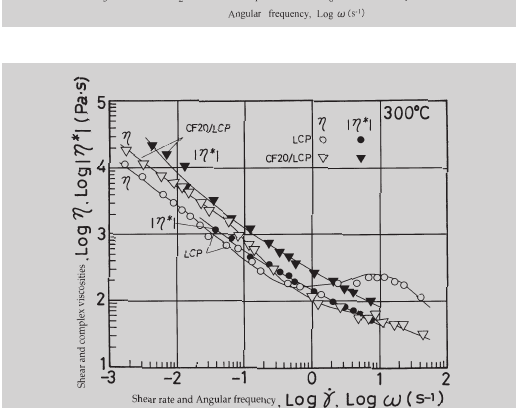
Figure 10 (abvove): a.) Storage and b.) loss moduli, G’ and G” of carbon black (CB) filled LCP as a function of angular frequency, w, at 300˚C. Figure 11 (below): Relationship between shear viscosity, h , and complex viscosity, |h*|, and shear rate, g · , and angular fre- quency, w, for pure LCP and carbon fiber compounds at